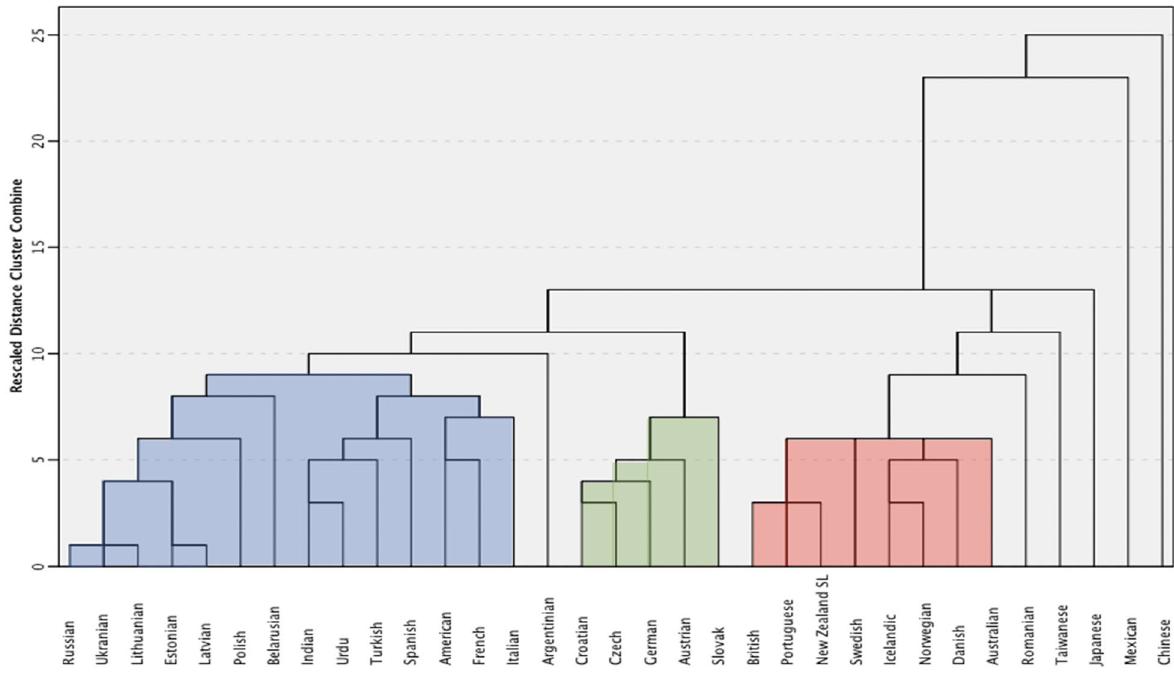
Figure 5. The dendrogram illustrates the three language families revealed by the hierarchical cluster analysis that was conducted on the handshape frequencies of 33 languages. Languages were historically related to French (blue) or Northern-European languages (red), or they were part of the central-European group